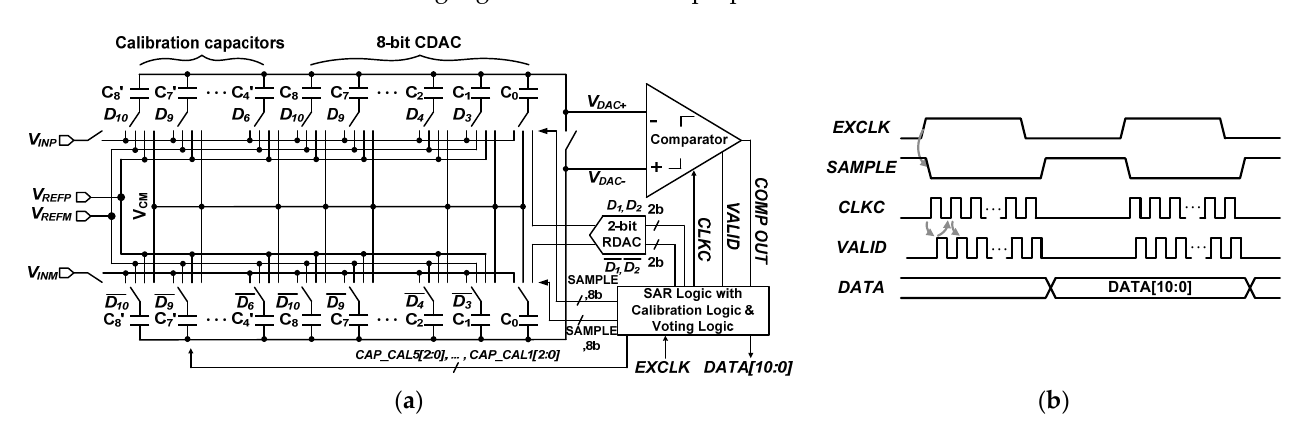
Figure 1. Proposed SAR ADC: ( a ) block diagram; ( b ) timing diagram.